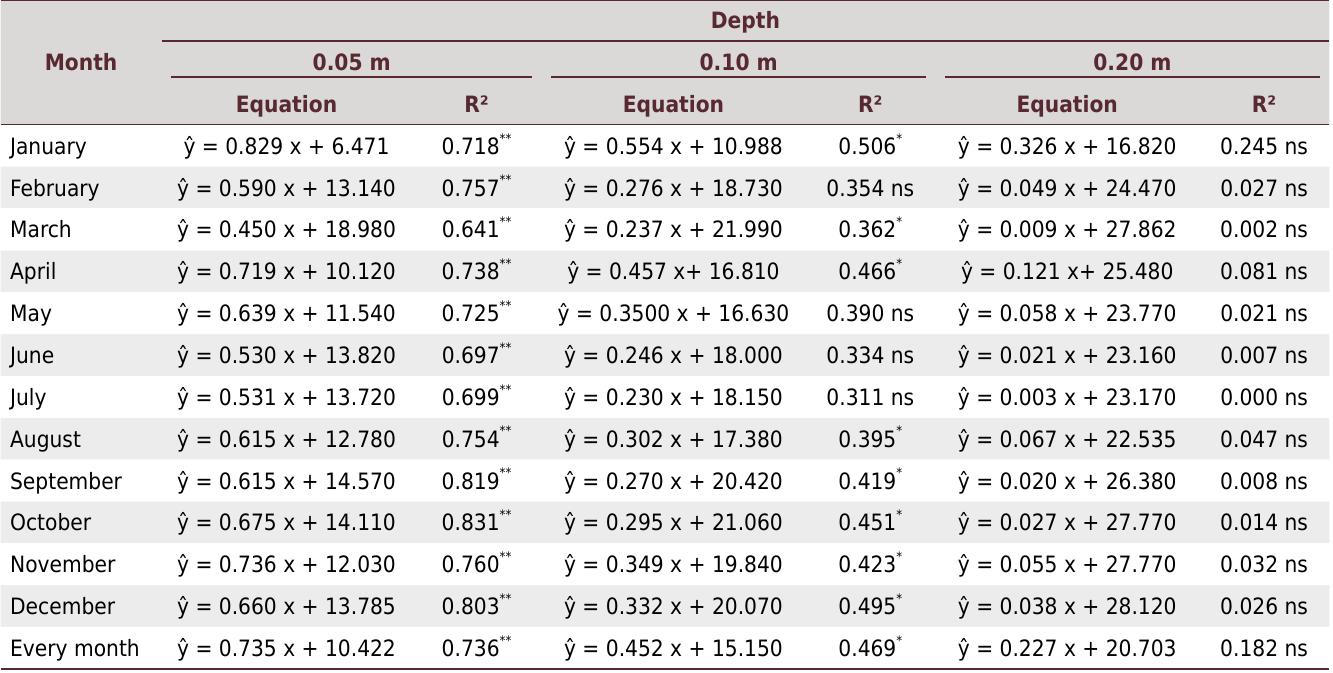
Table 5. Linear regression equations developed for air and soil temperature from April, 2015 to March, 2016, considering three depths of Cambissolo Háplico Ta Eutrófico (Cambisol; Inceptisol), in São Gabriel, Irecê Identity Territory, Bahia,